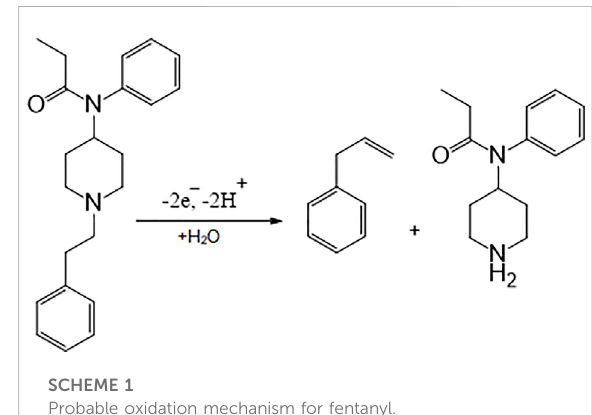
SCHEME 1 Probable oxidation mechanism for fentanyl.